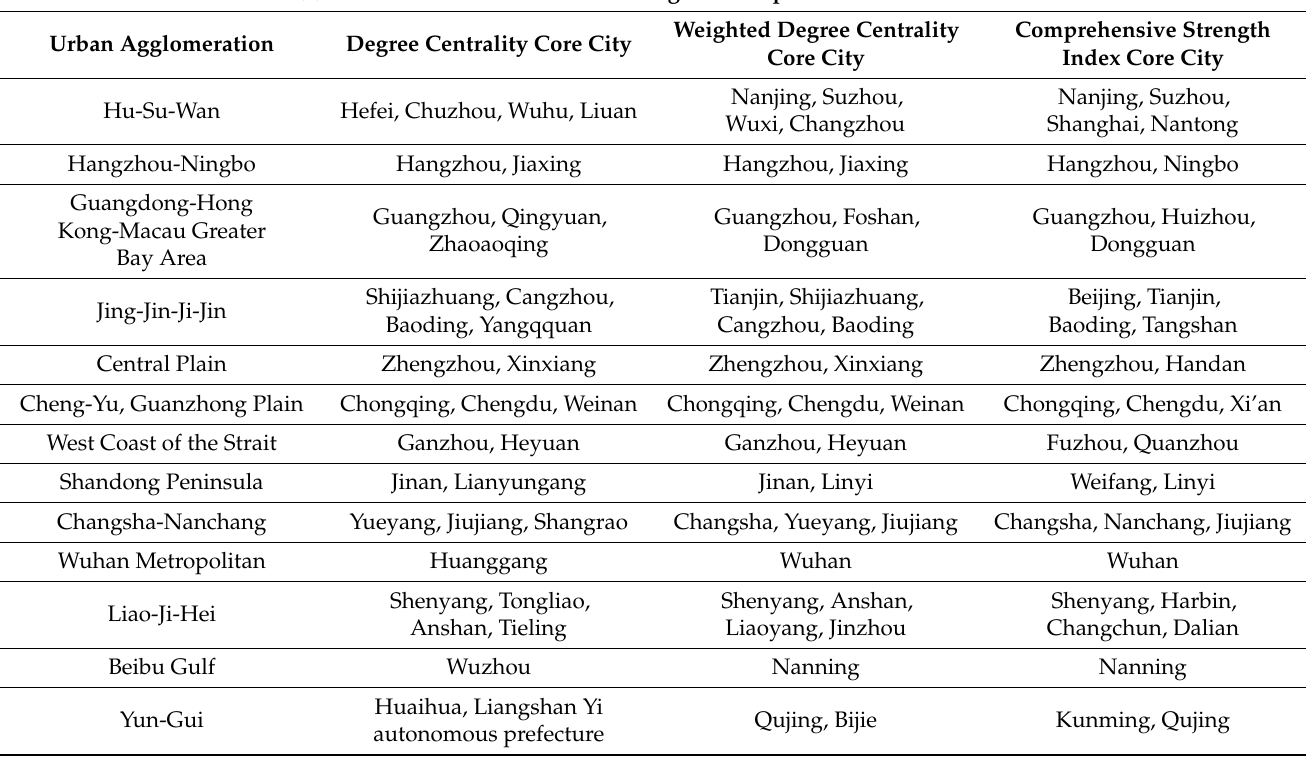
Table 4. Cont. (3) Identification of Core Cities Using the Composite Urban Network.